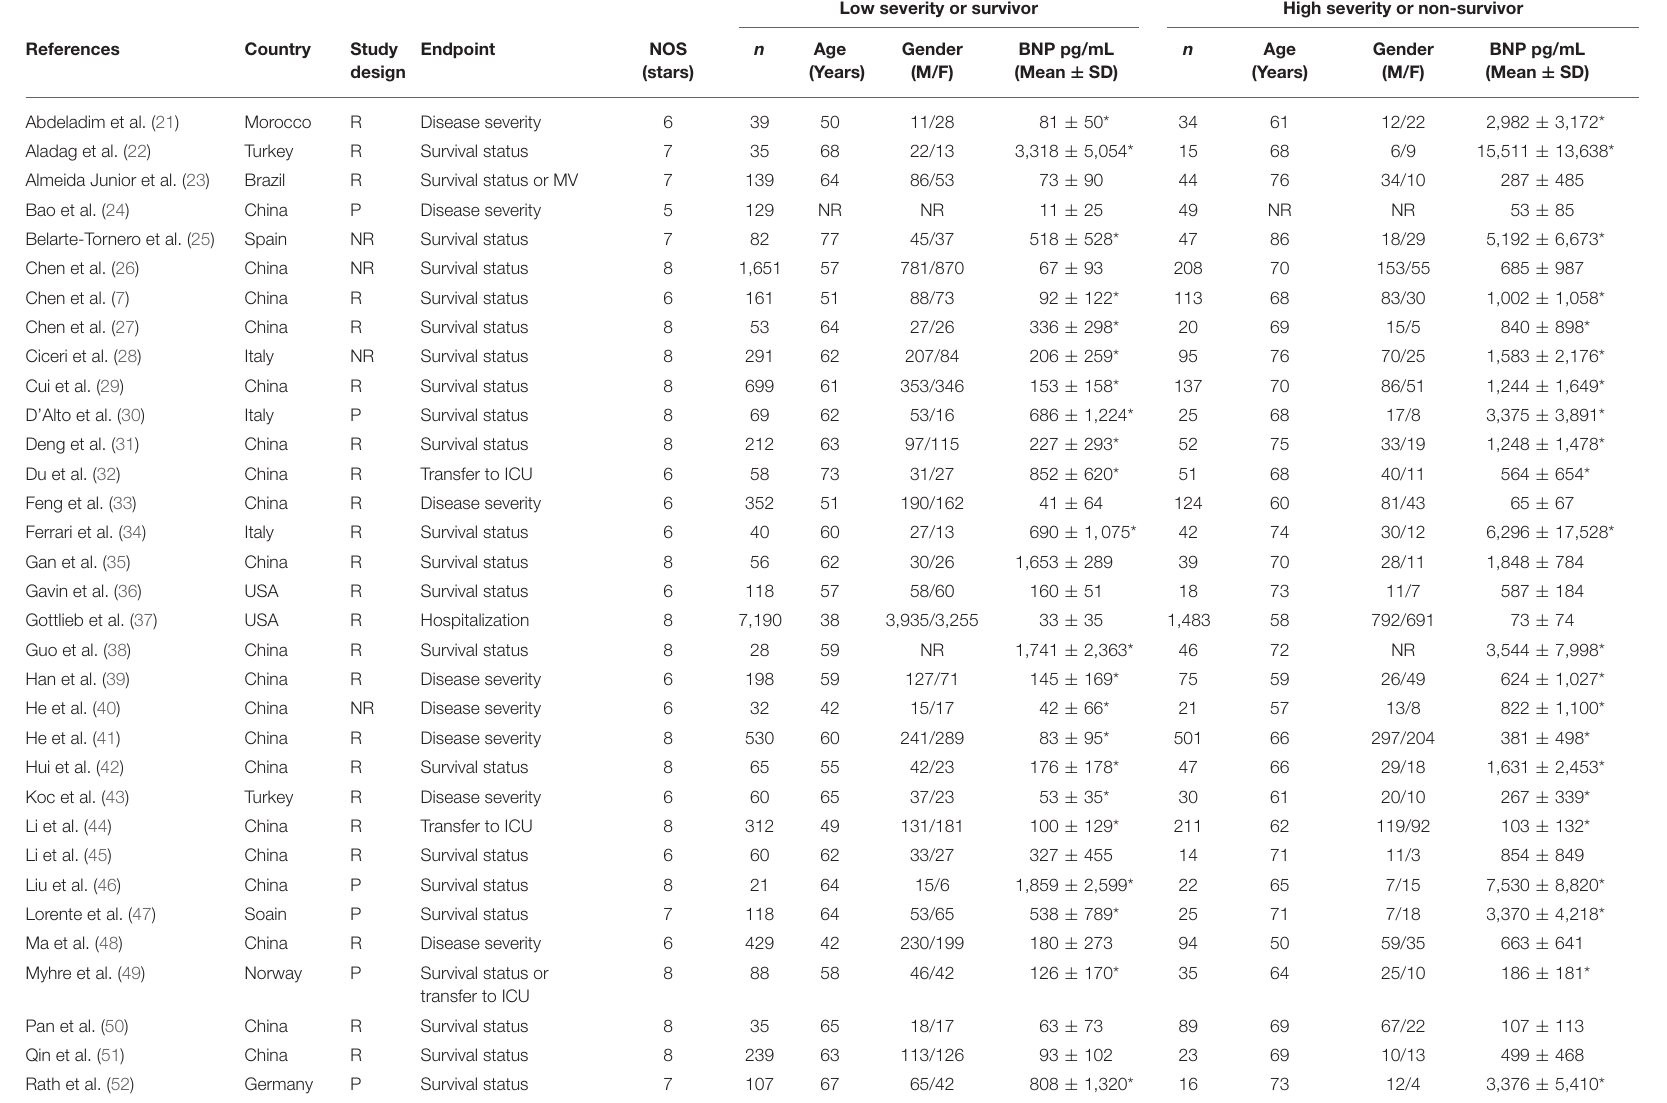
TABLE 1 | Characteristics of the selected